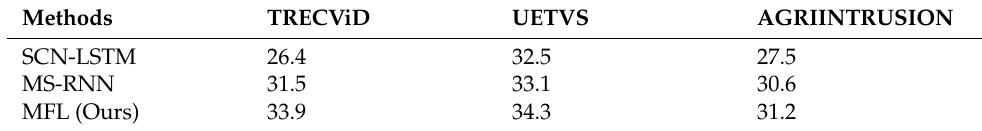
Table 1. METEOR score